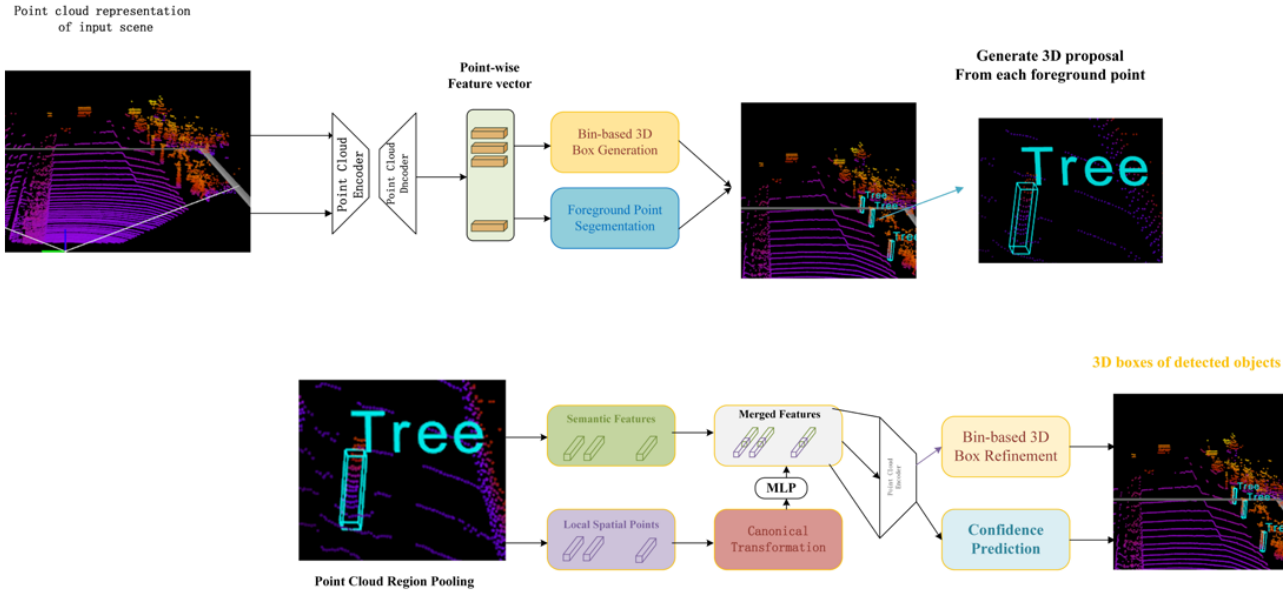
Figure 2. PiontRCNN network overview.